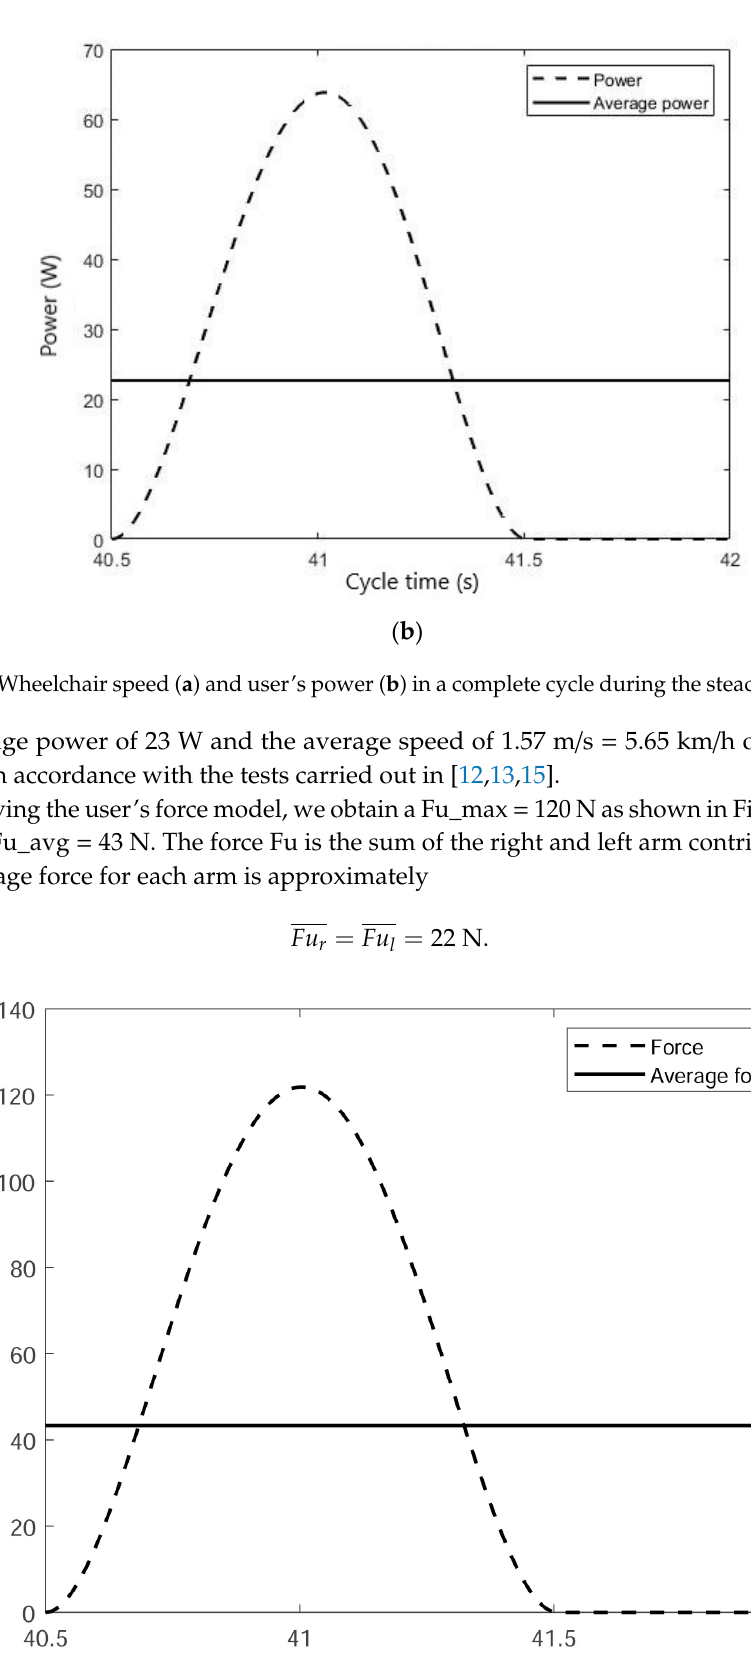
Figure 17. User’s force during the steady-state phase.